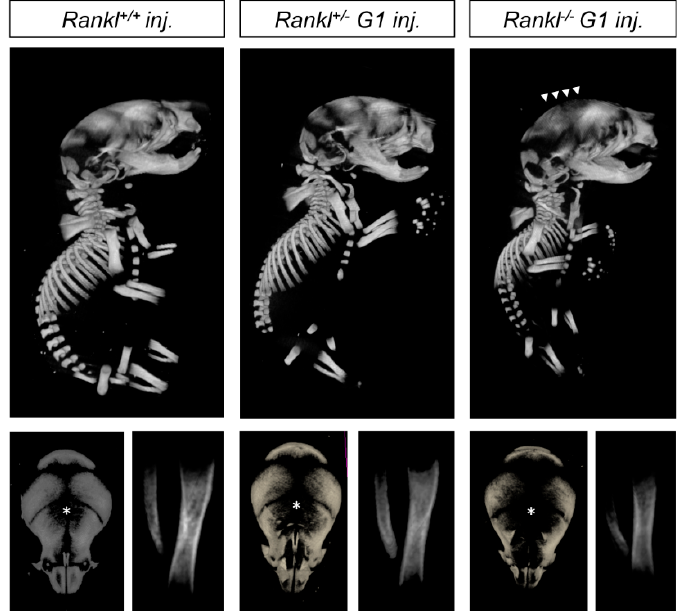
Figure 6. MicroCT comparative analysis of the skeletons of wild type, heterozygous, and first-generation Rankl null mutant pups born from females treated with IK22-5 during the second half of pregnancy. A graduated skeleton phenotype was observed from wild type to null mutant pups, with the presence of an enlarged foramen (star and arrowheads) in all genotypes. Percentage of closure measures (surface) for the different genotypes are 87 ± 3 for +/+, 68 ± 4 for +/ − , and 60 ± 4 for − / − . Globally, it seems that injections of IK22-5 increased the phenotype of each genotype to the next in terms of severity, wild type being comparable to non-injected heterozygous, heterozygous to non-injected first-generation null mutants, and first-generation null mutants to second-generation phenotypes. Numbers of pups: 3 +/+, 6 +/ − , and 2 − / − .